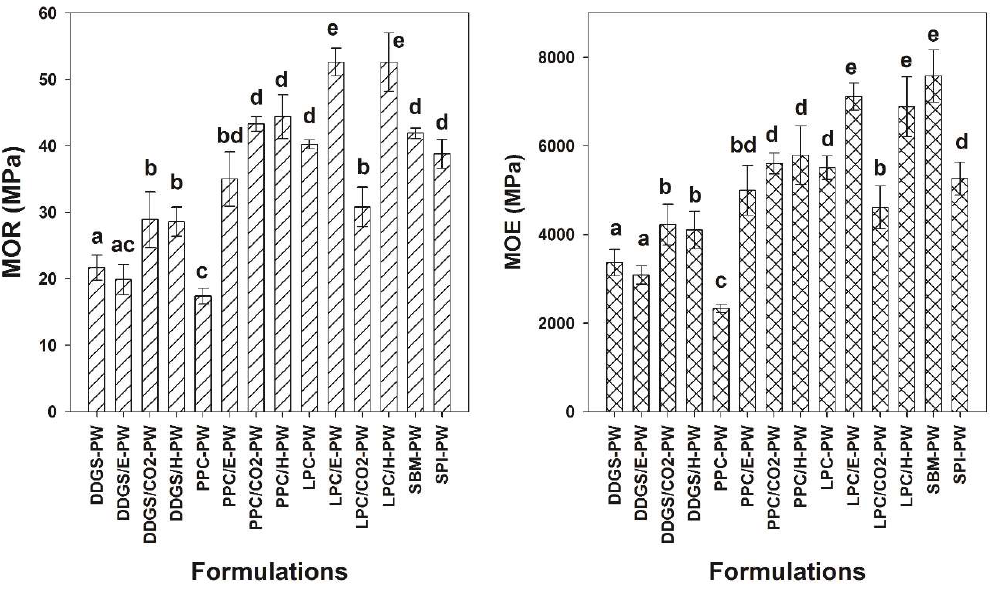
Figure 3. Mechanical properties of various panel formulations Means and standard errors are presented; treatment having different letters were significant (P ≤ 0.05).